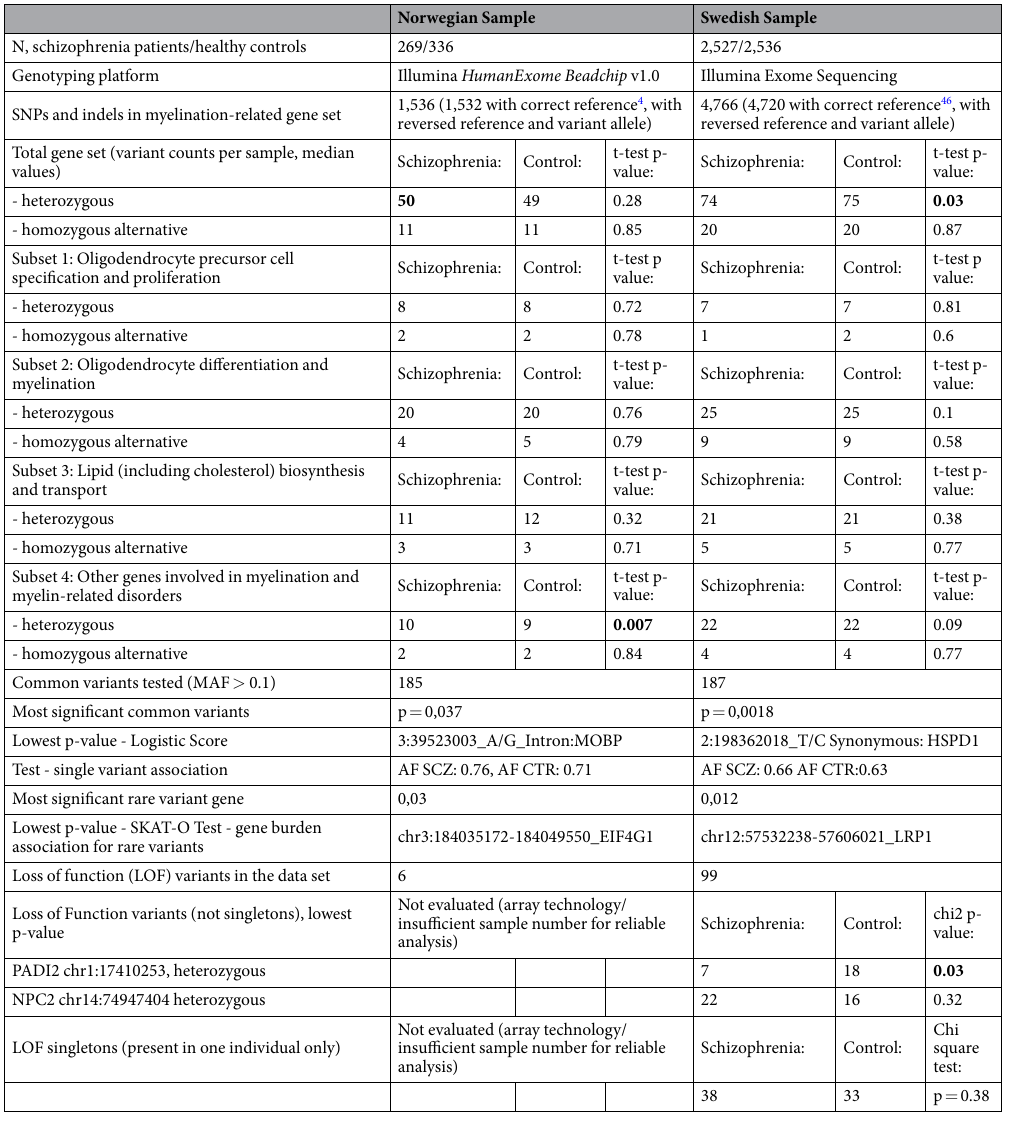
Table 2. Overview of the distribution of common and rare variants in myelination-related genes in schizophrenia patients and healthy controls. Table summarizes variant load per subject, single variant association, gene burden association and loss of function variant analysis. T-test and chi2 test values were computed in R. Significant differences are marked with bold font, however they did not survive correction for multiple testing (q >